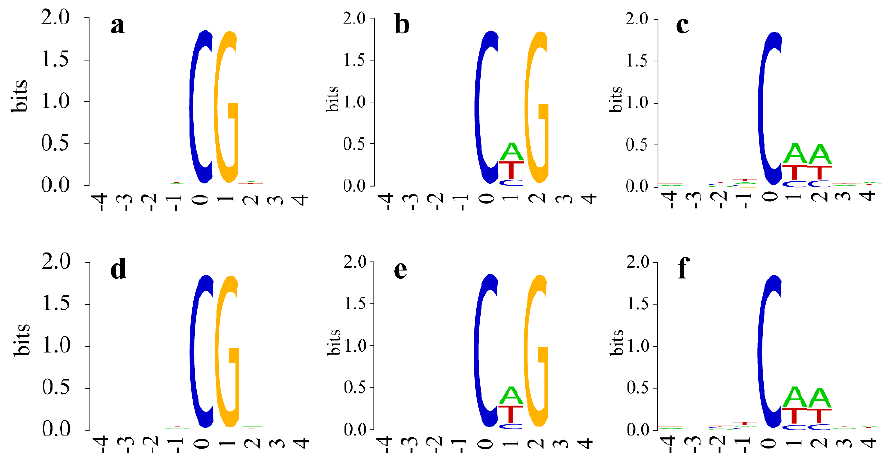
Figure 3. Characteristics of 9-base pair sequences with methylated CG, CHG and CHH (H = A, T, or C) in pecan. ( a – c ) represent the sequence characteristics in the Watson strand, and ( d – f ) represent that in Crick strand. The abscissa refers to the position of bases at the methylation sites and the height of base signal at each position refers to the relative frequency of the bases at that position. The graphs were obtained based on the methylation data of SV1 pecan graft (One of the three pecan grafts with strong growth vigor).